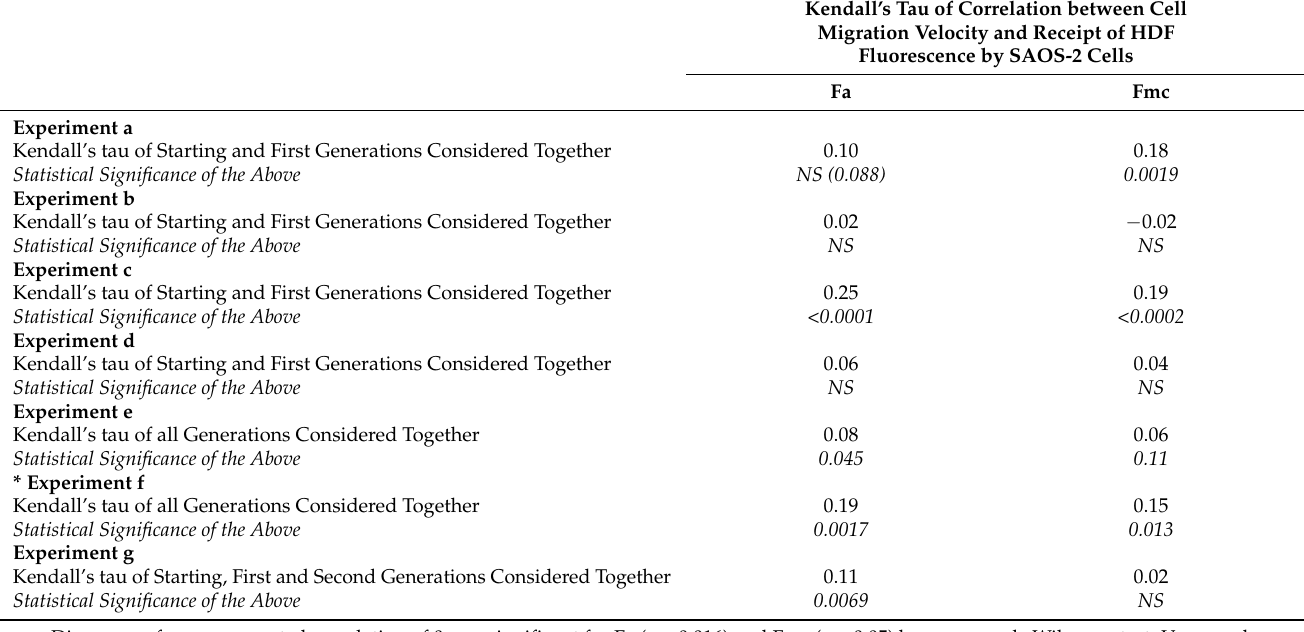
Statistical statements are in italics to aid visual interpretation, and exact values for p are given when these were